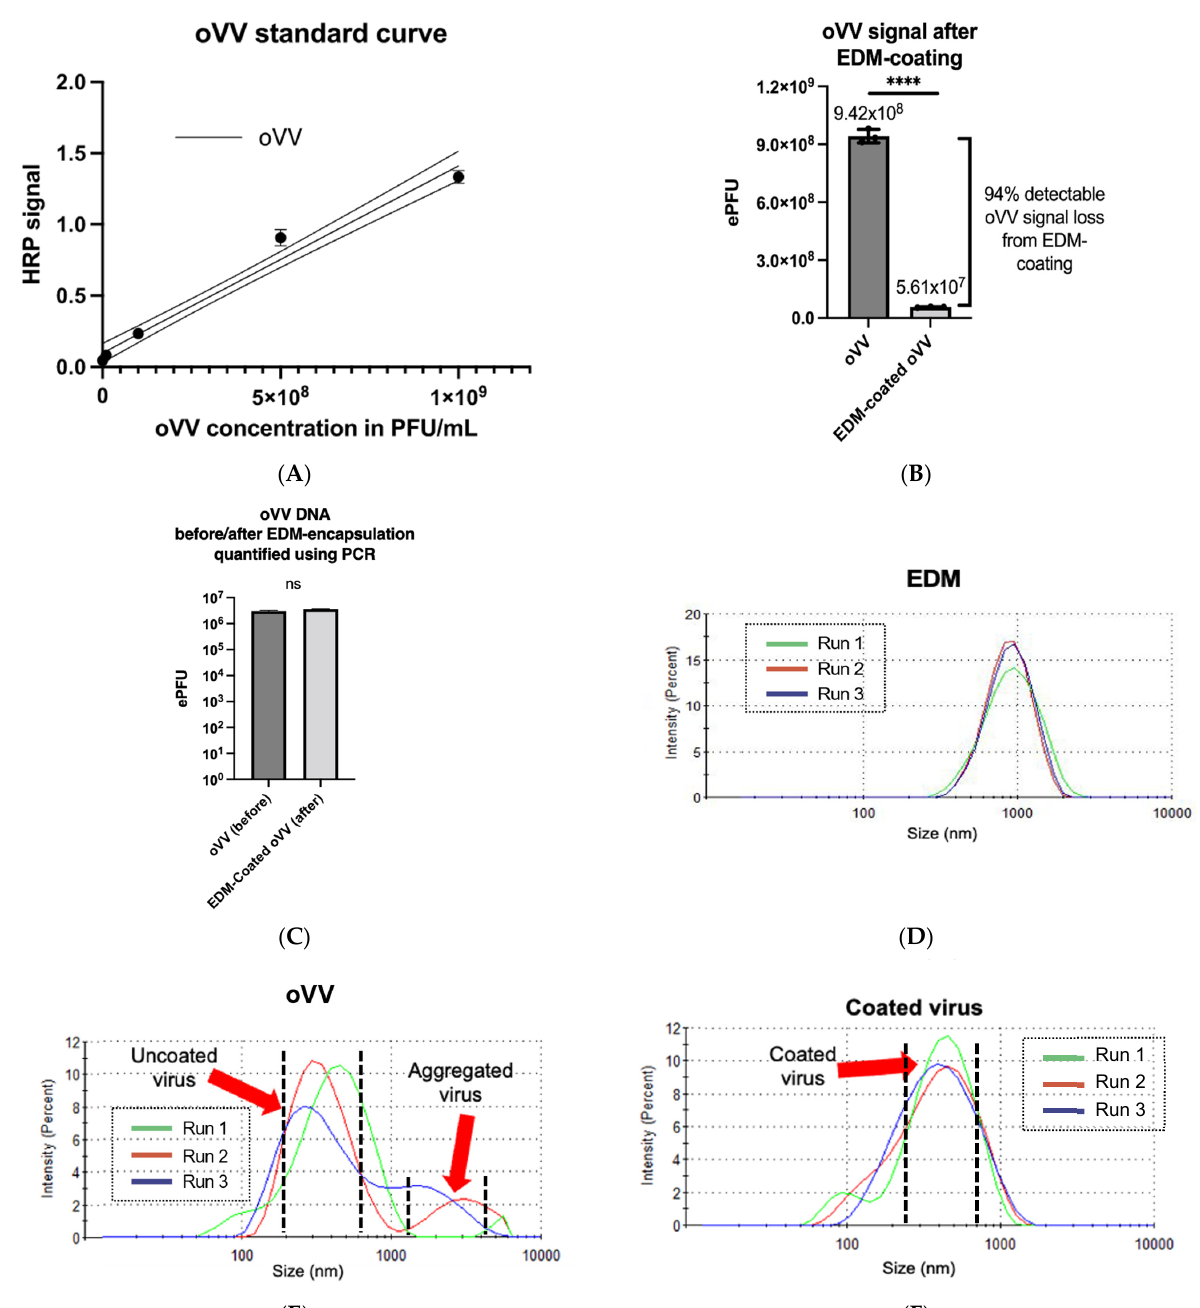
Figure 2. ( A ) oVV standard curve generated via ELISA assay. Dotted lines above and below the solid line denote a 95% confidence in the values of the assay. ( B ) Detectable oVV signal before and after processing with EDM, interpolated from the ELISA standard curve. Results are presented as mean ± SD, n = 3. Data were analyzed with ANOVA with Tukey pairwise comparison test. The level of statistical significance was set at probability level **** p < 0.0001. ( C ) oVV DNA before and after extrusion as quantified using PCR. Results are presented as mean ± SD, n = 3. Data were analyzed with ANOVA with Tukey pairwise comparison test. The level of statistical significance was set at probability level ns p ≥ 0.05. ( D – F ) Particle size measurements of the ( D ) EDM, ( E ) oVV, and ( F ) EDM-coated oVV, measured across 3 dynamic light scattering